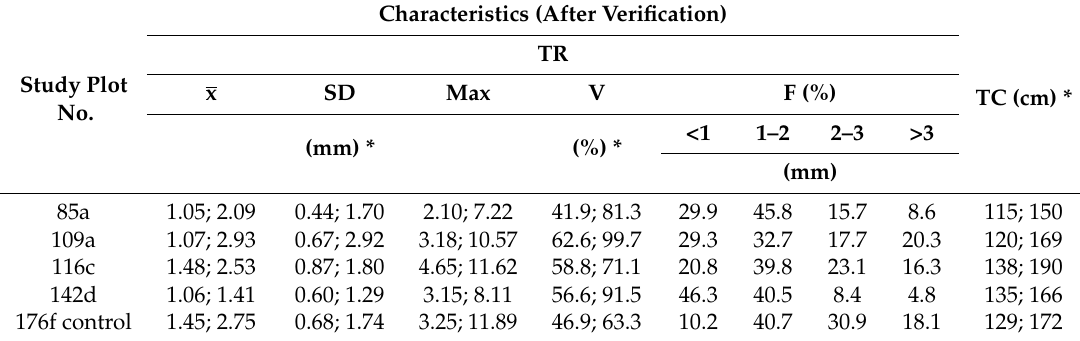
Table 3. Characteristics of tree rings included in the construction of site